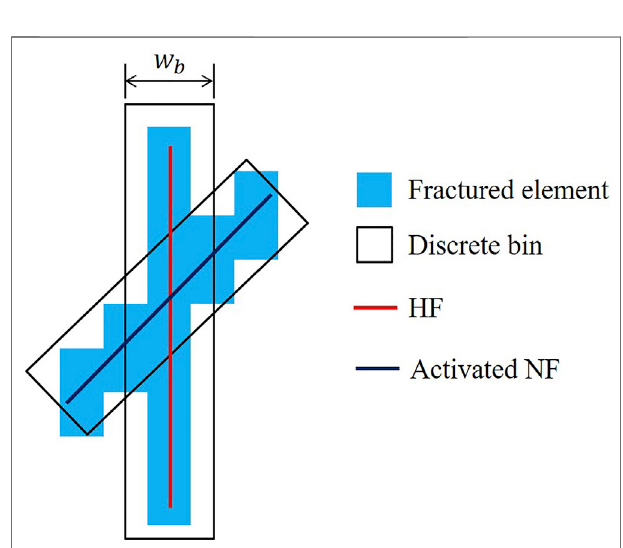
FIGURE 2 | Discrete bins method for the SRV